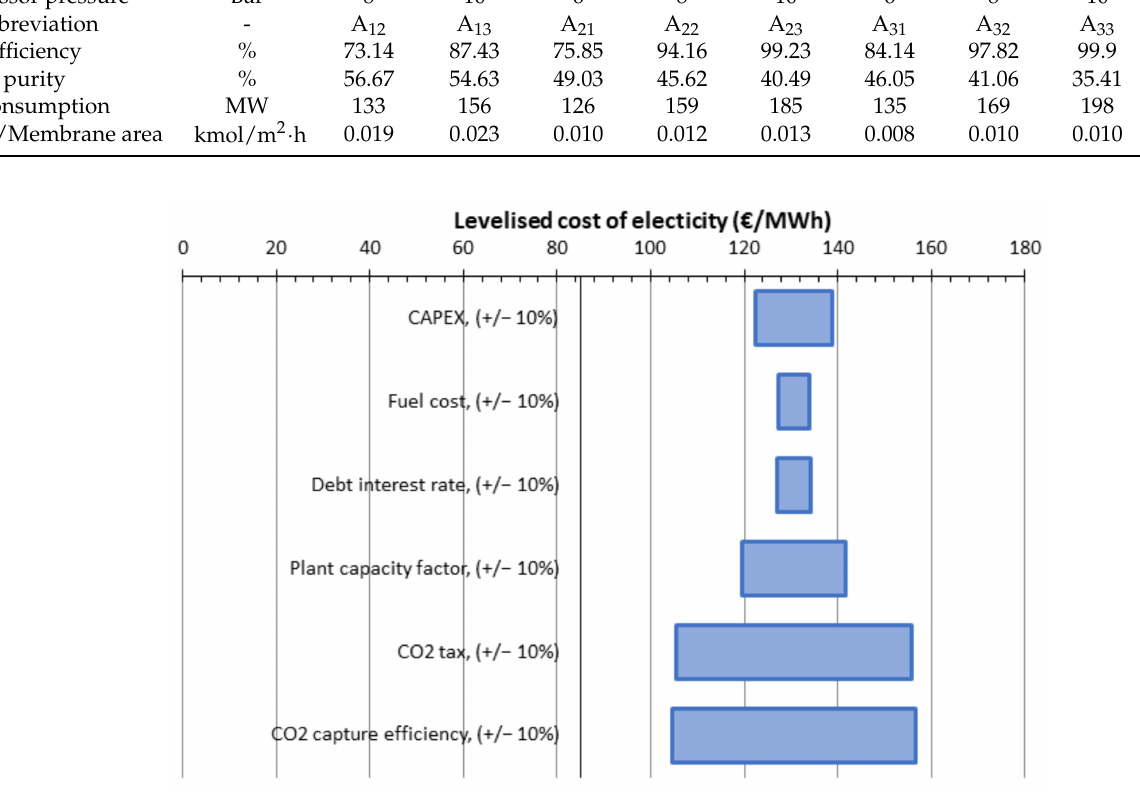
Figure 27. LCOE variation according to different